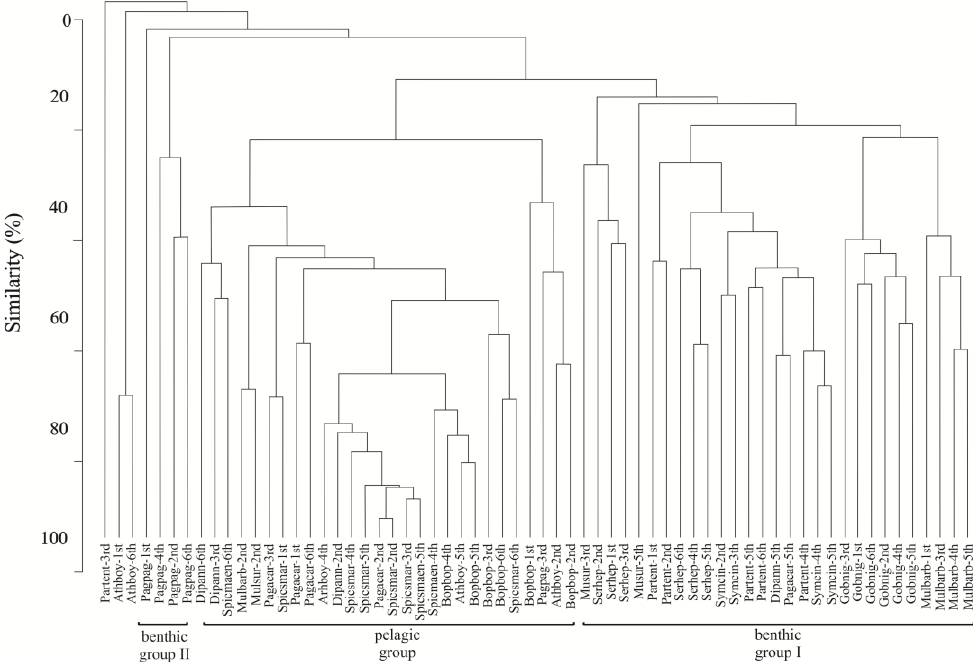
Figure 2. Similarity dendrogram based on the relative abundance of prey taxa matrix of the common fish species examined during the six sampling occasions in the study area.